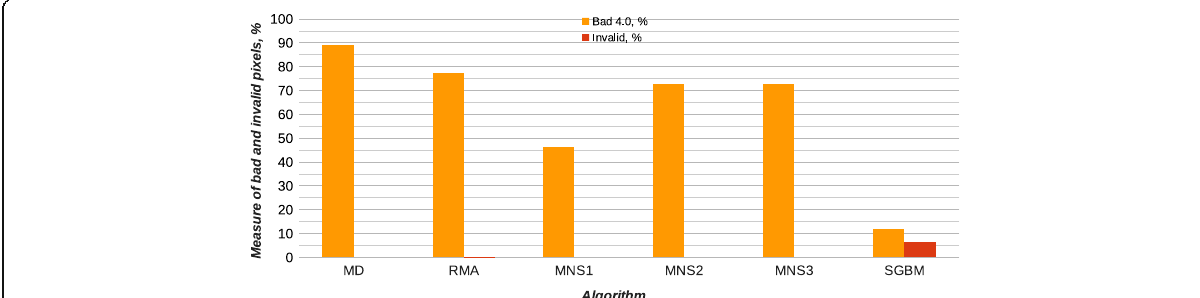
Fig. 9 Average percentage of bad pixels, whose error is larger than 4 pixels, and average percentage of invalid pixels. Evaluation performed using Q resolution training set images